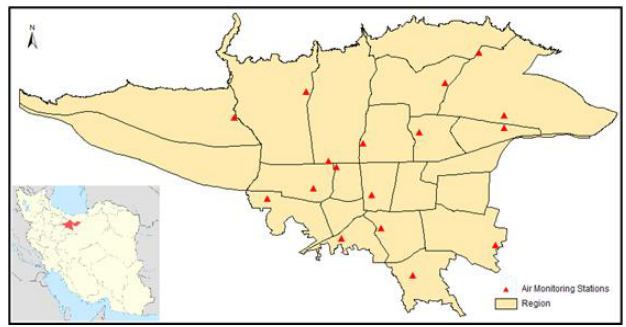
Figure 1. The study area and distribution of air pollution monitoring